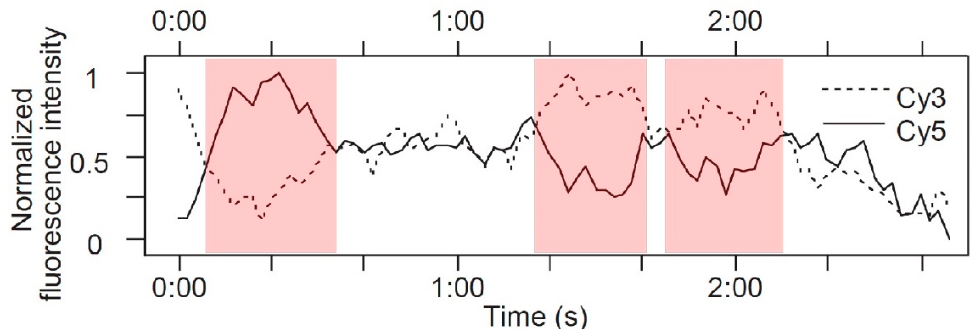
Figure 3. Typical anticorrelated single molecule traces showing the presence of single-molecule Förster resonance energy transfer (smFRET) (adapted from Sako et al. [46]). The presence of FRET is shown by increases in acceptor (Cy5) fluorescence and decreases in donor (Cy3) fluorescence (highlighted in red).